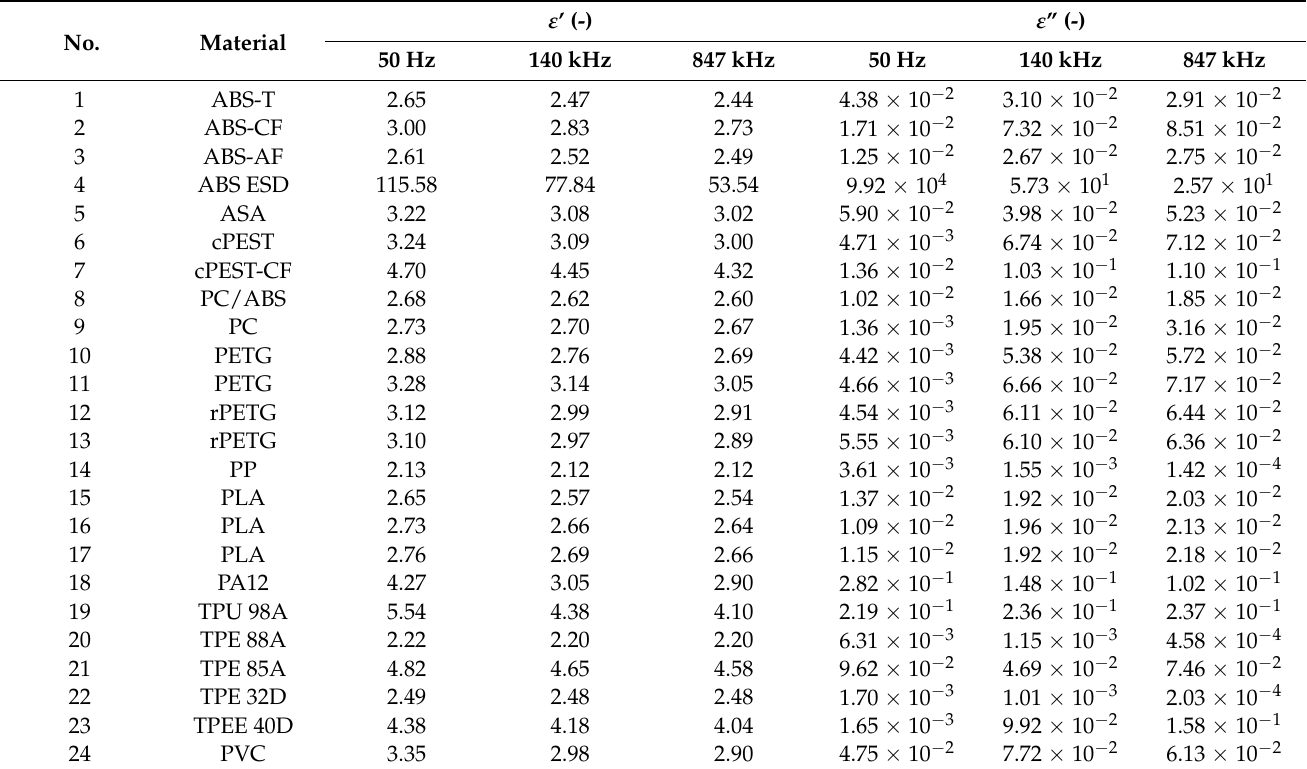
representing the subcarrier frequency of the RFID/NFC communication, which is used for data transmission from the passive card to the reader [56,57]. Table 4. Summary of the dielectric constant and loss factor values for all tested materials at three selected frequencies.